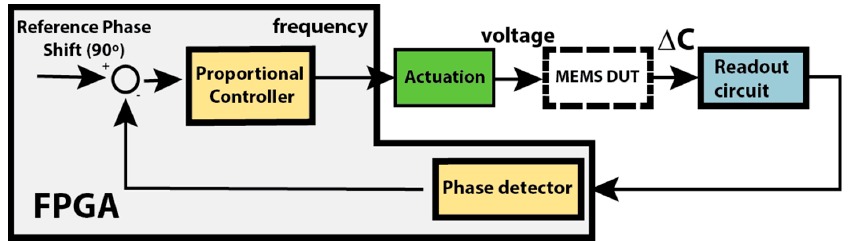
Figure 6. Resonant frequency proportional controller blocks.